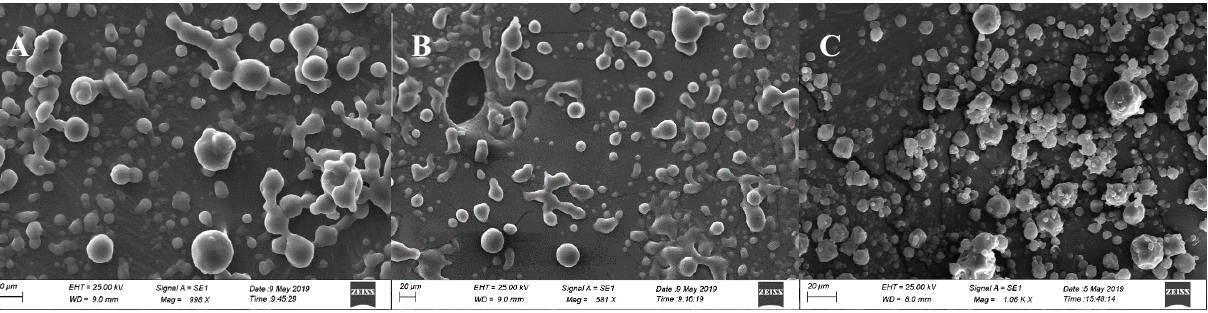
Figure 4. Powder morphology of spray-dried powders stored at 37 °C and 0.33 a w condition for 4 weeks. ( A ) Large-size powder, LP, ( B ) Small-size powder, SP, ( C ) Nano-size powder, NP. As previously reported by Yoshii, et al. [26], the n of the Avrami equation was related to the release mechanism. Theoretically, the release equation for d-limonene should follow zero-order kinetics; n should be zero and the release rate of flavor should be constant. However, due to several factors, the release kinetics are not always of zero order. As shown in Scheme 1b, at the lower a w values of 0.25 and 0.33, the n of the three powders is below one, indicating that the molecular diffusion rate of d-limonene was limited, with only SP having an n of 0.99 at a w values of 0.33, representing a first-order reaction release mechanism. At high a w (0.75), n was greater than one, indicating that the increase in water activity has a significant effect on the release of d-limonene.